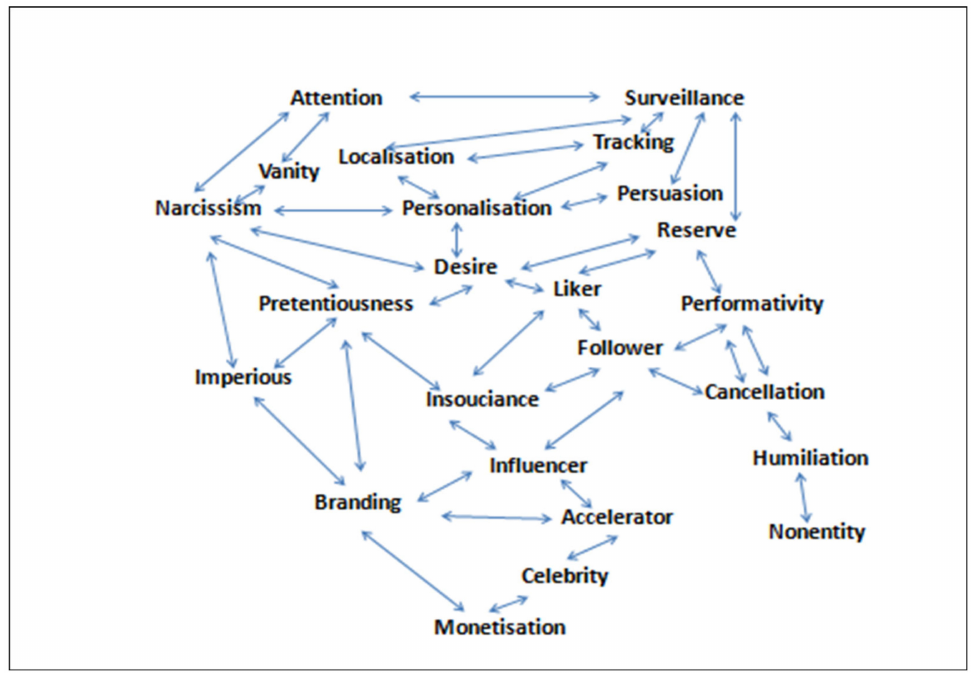
Figure 1. Pattern Recognition Diagram of PSC Cognitive Model. Source: